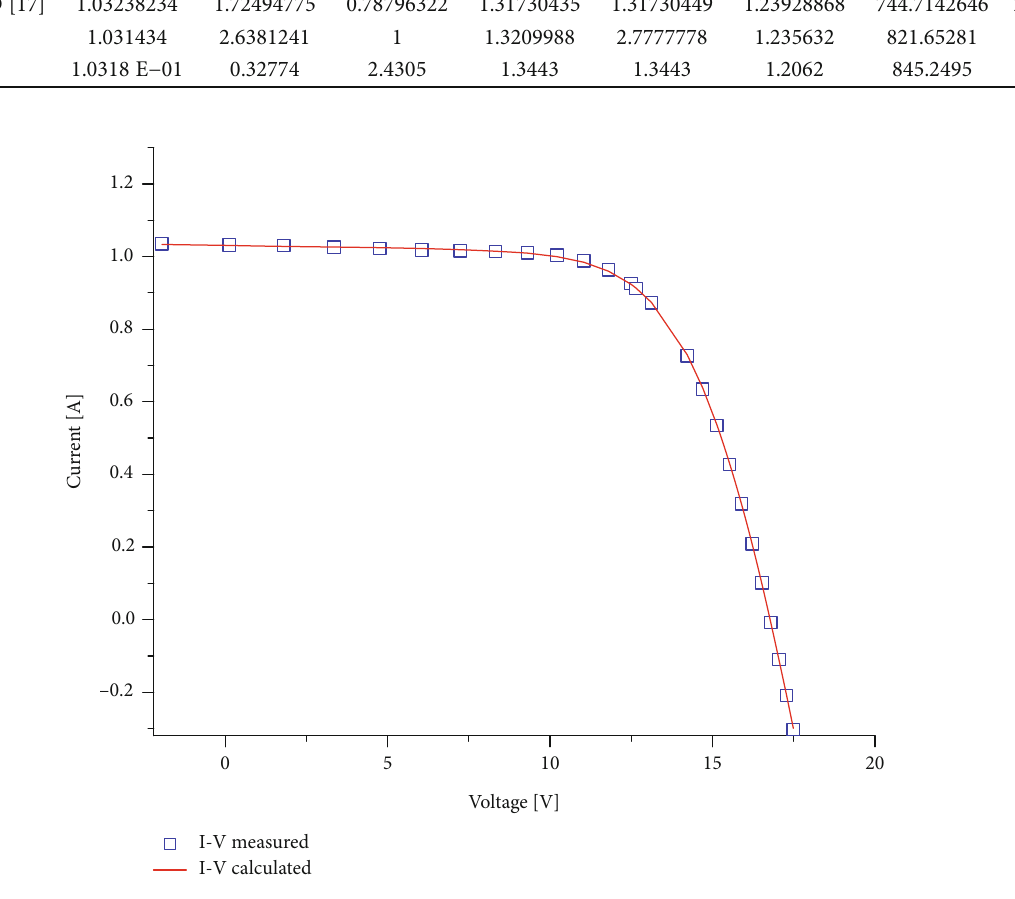
Figure 7: The I-V characteristics for PWP201 photovoltaic panel.